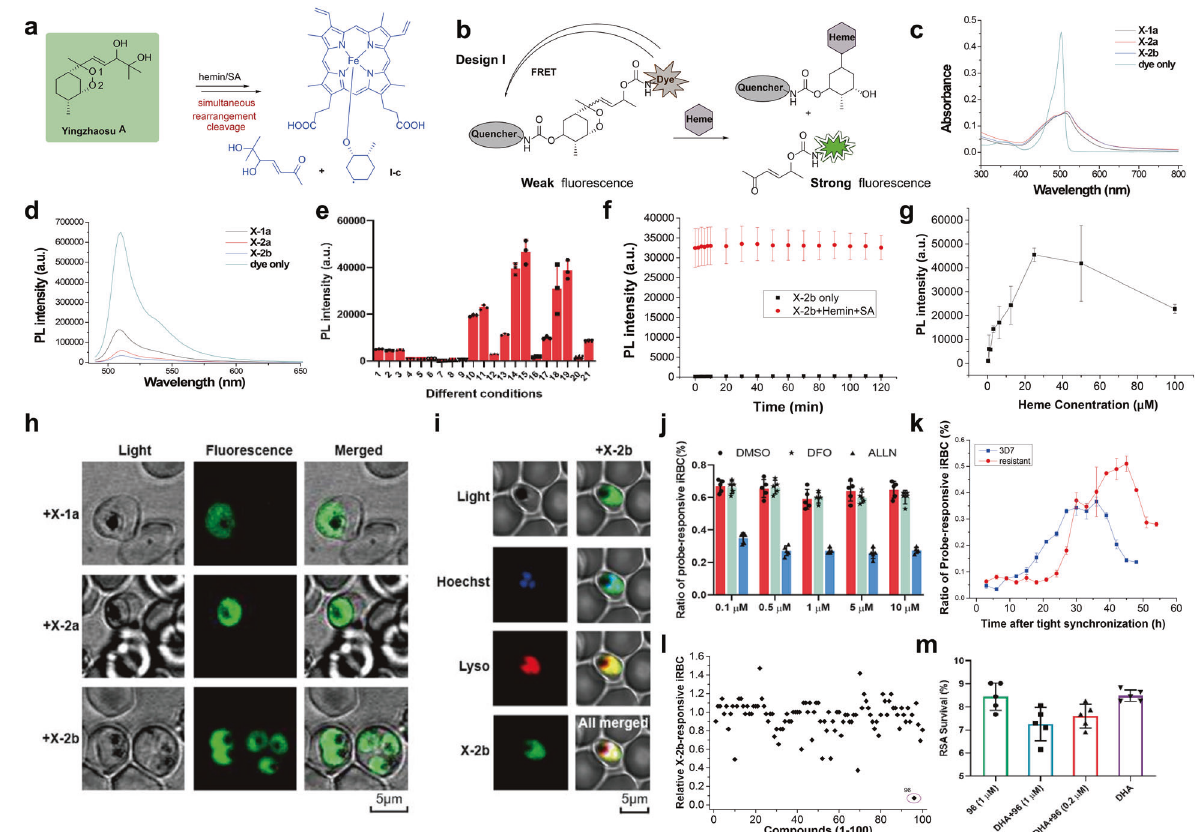
X-1a, X-2a, X-2b and the BODIPY fl uorophore in PBS (5 μ M). d PL spectra of X-1a, X-2a, X-2b and the BODIPY fl uorophore in PBS (5 μ M). e PL intensity of three probes incubated with/without heme under different conditions for 2 h. The different conditions were as follows: 1, X-1a;